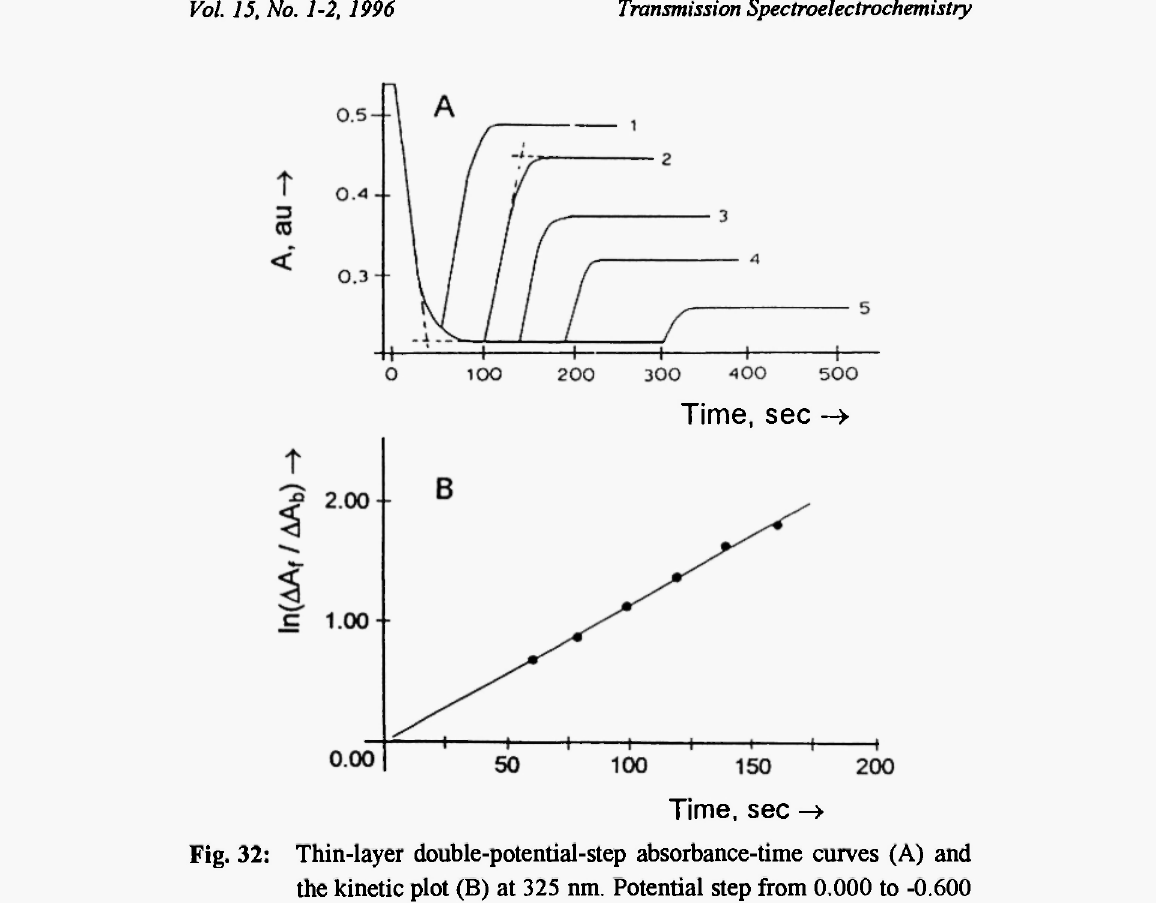
Fig. 32: Thin-layer double-potential-step absorbance-time curves (A) and the kinetic plot (B) at 325 nm. Potential step from 0.000 to -0.600 to +0.300 V vs. SCE. 1 mM azobenzene, 0.100 Μ HCl, 44% ethanol. f = (1) 50, (2) 100, (3) 150, (4) 200, (5) 300 sec. (From R Ref.